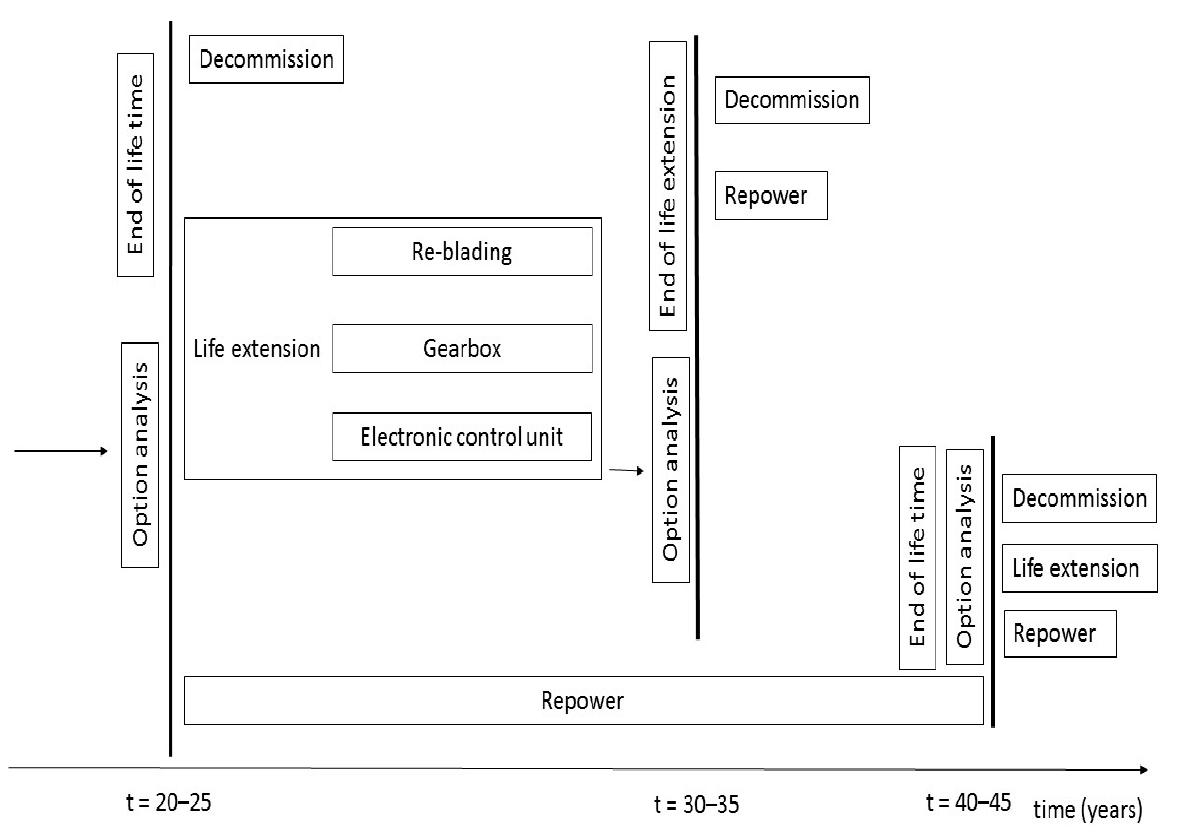
Figure 4. Options associated with units near the end of their lifetimes.